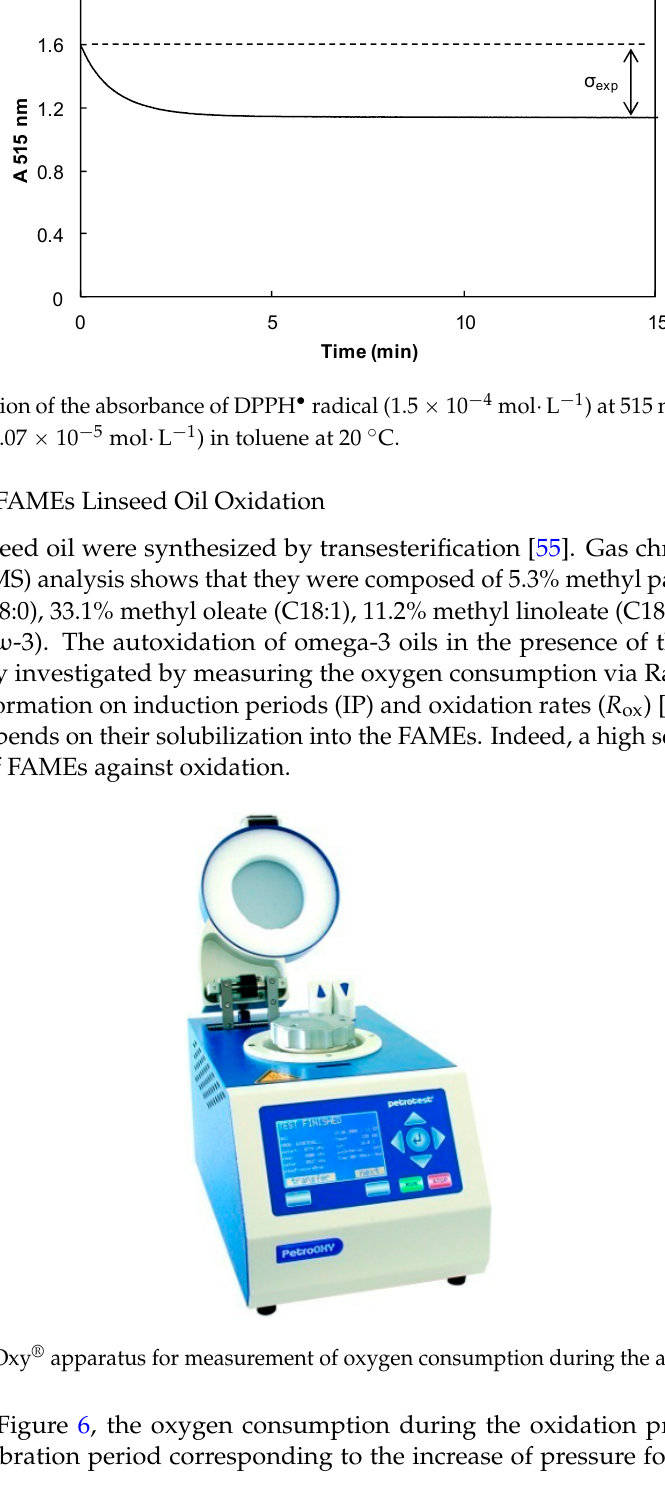
autoxidation process